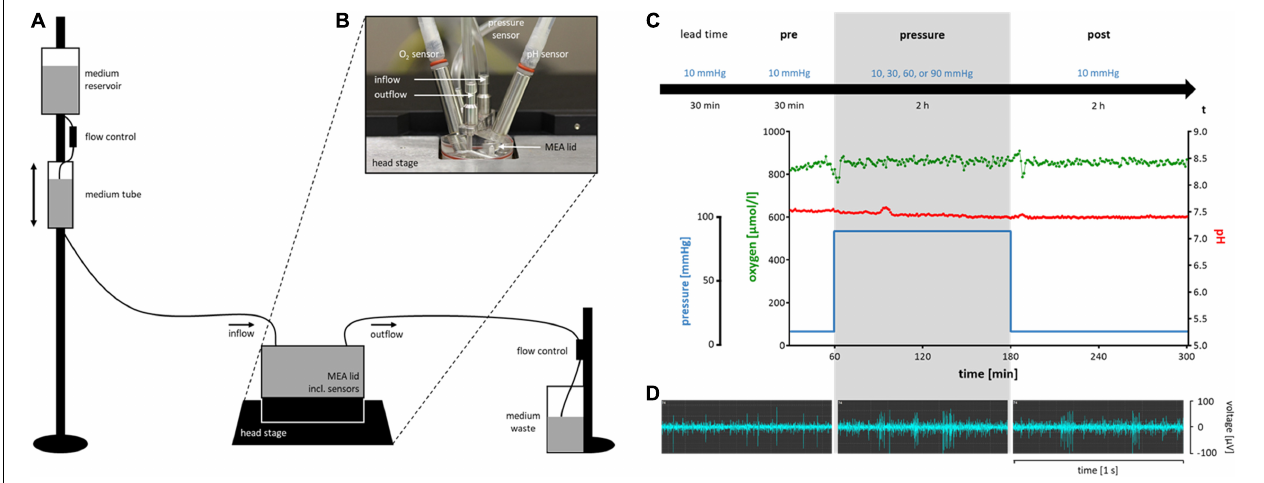
FIGURE 1 | Schematic diagram of the experimental setup of the pressure model and timeline with representative experimental conditions and RGC activity. (A) A simplified sketch of the experimental setup for the pressure model (not to scale). (B) The MEA lid on top of a MEA. The five integrated access points for in-, and outflow of the perfusion system, and for pressure, O 2 , and pH sensors are shown. (C) The experimental timeline including a lead time of 30 min at 10 mmHg, the pre-phase of 30 min at 10 mmHg, the pressure-phase of 2 h at either 10 (control), 30, 60 or 90 mmHg, and the post-phase/recovery time of 2 h at 10 mmHg. Below the timeline, representative examples of pressure level, oxygen concentration, and pH of an experiment with 90 mmHg are shown. Note that during changes in the pressure level, [O 2 ] and pH remain stable. (D) Representative examples of the electrical spontaneous RGC activity of a wt mouse retina in the pre-, pressure-, and post-phase of an experiment with 90